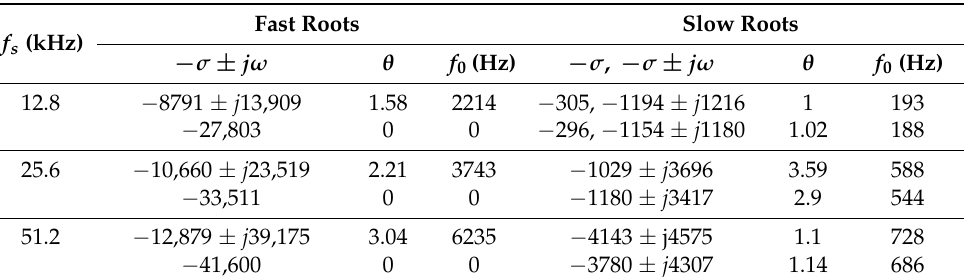
Figure 17. Root loci for the load mode. ( a ) general view, ( b ) dominating poles with C ( s ) (zoom), ( c ) dominating poles with no-delay C ∗ ( s ) (zoom). Crosses—open loop poles, circles—zeros, dots— closed loop poles. Controller optimized under assumption of ∆ A = 1.1 for the no-load mode. Note that, unlike the other roots, the roots for f s = 12.8 kHz do not depart significantly from the open loop poles. As a result, the real root close to zero dominates the closed-loop dynamics Note the weak effect of delays on the poles positions. Table 3. Roots in the load mode First row: with C ( s ) , second row with C ∗ ( s ) .